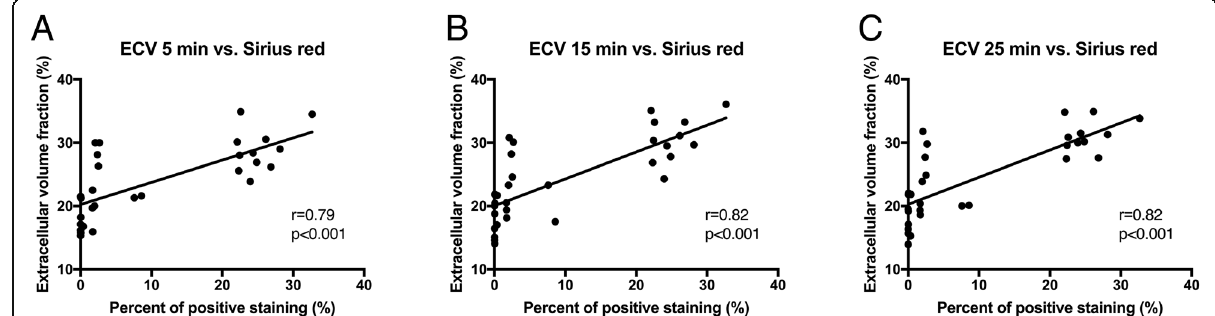
Fig. 3 Scatter plots showing correlations between extracellular volume (ECV) fraction and positive staining for Sirius red 5 ( A ), 15 ( B ), and 25 min ( C ) after contrast